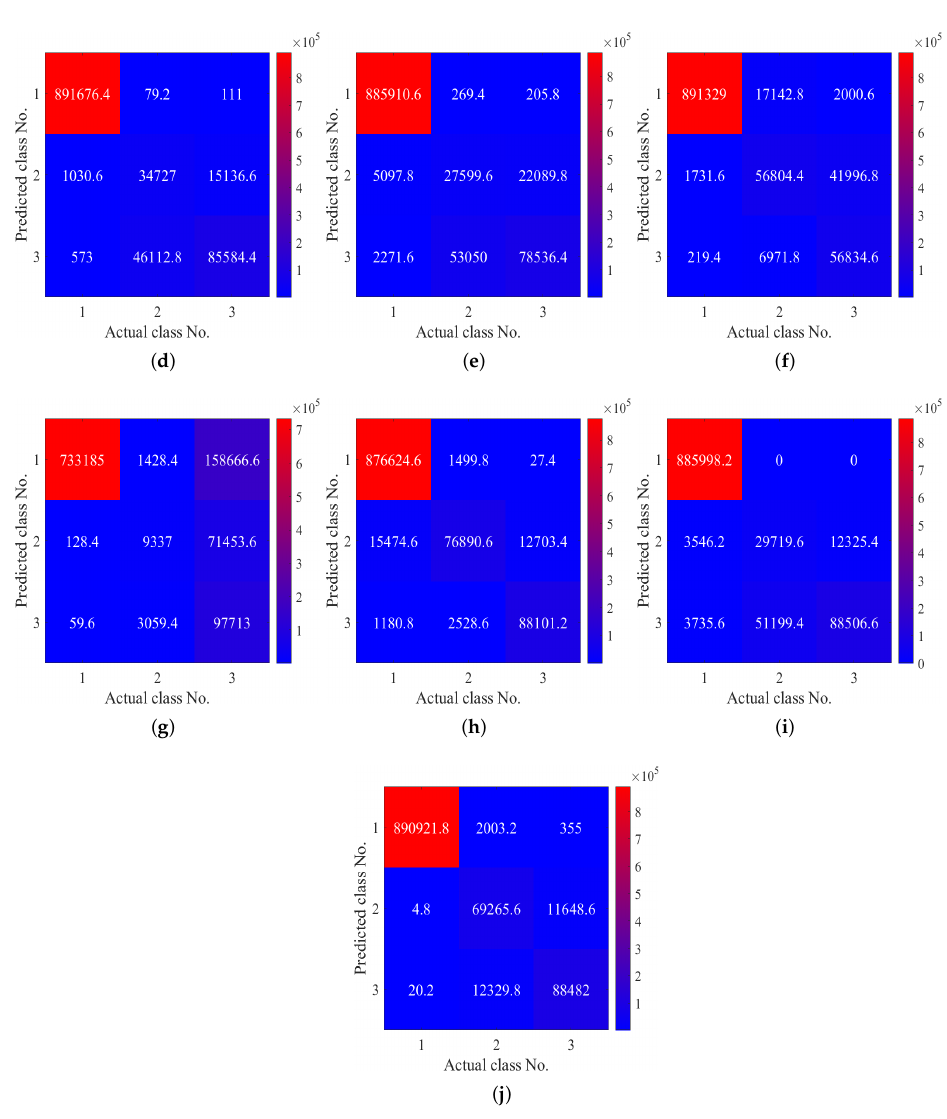
Figure A2. Confusion matrixes of classification results for Flevoland with different methods. ( a ) SVM.